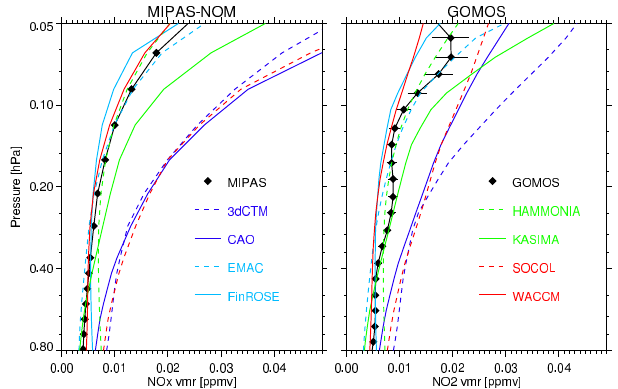
Figure 13. Left: MIPAS-NOM and modelled mean NO x profile for the period 15 December 2008–12 January 2009 within 70–90 ◦ N. Right: GOMOS and modelled mean night-time NO 2 for the same period within 75–85 ◦ N. The error bars indicate random retrieval errors of the averaged observational